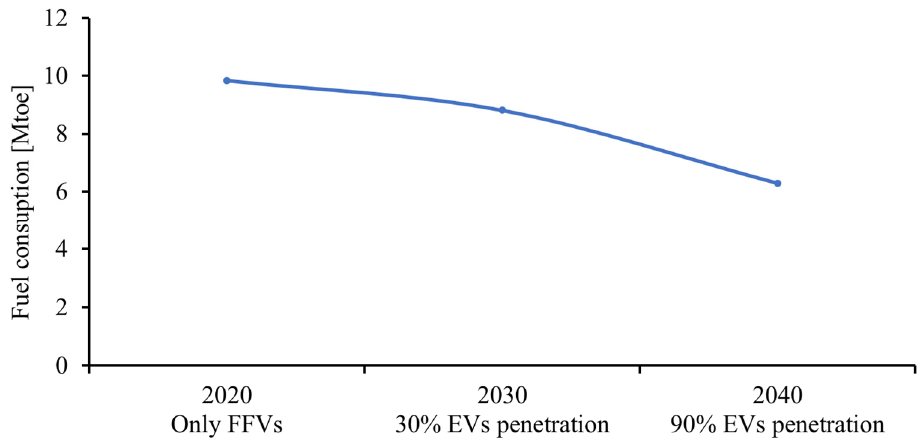
Figure 11. The decreasing trend of the fuel consumption with EVs penetration.